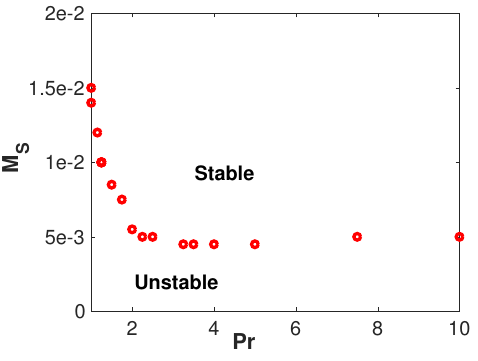
Figure 4. The stability boundary for (2,1) mode as functions of Prandtl number, Pr , and the amplitude of the stochastic ZFs, M S